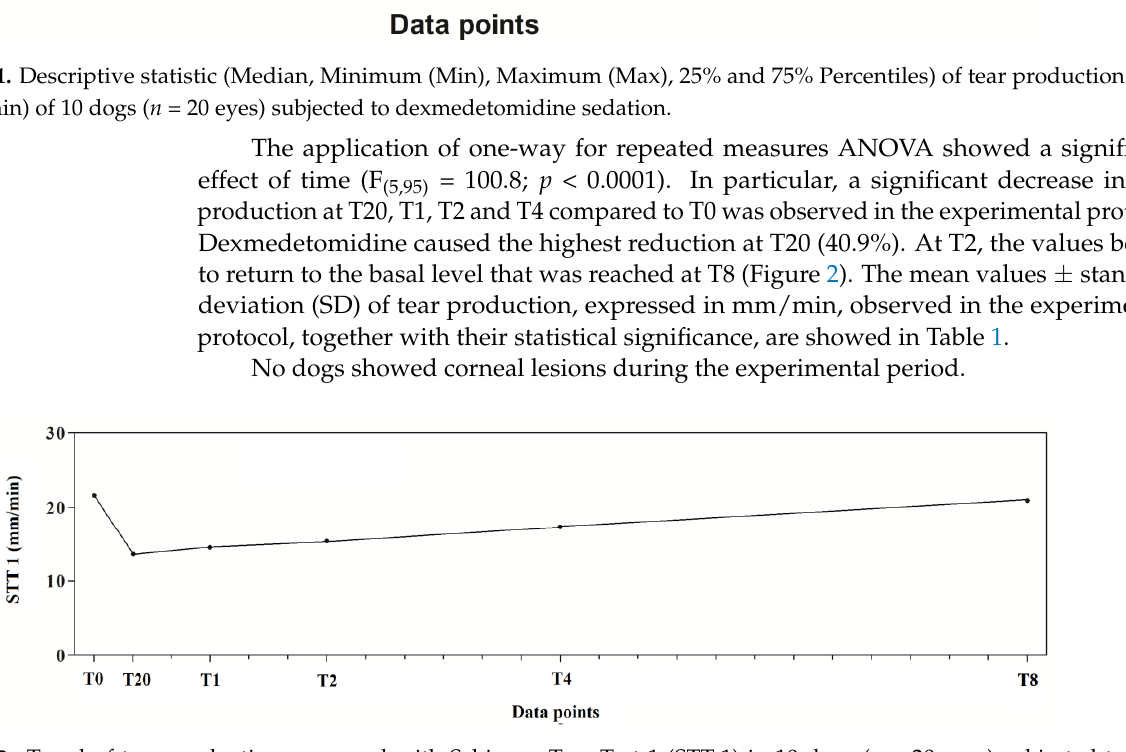
Figure 2. Trend of tear production measured with Schirmer Tear Test 1 (STT-1) in 10 dogs ( n = 20 eyes) subjected to dexmedetomidine sedation. Table 1. Mean values ± standard deviation (SD) of tear secretion recorded using STT-1, expressed in its conventional unit (mm/min) in all data points investigated, together with their statistical differences.